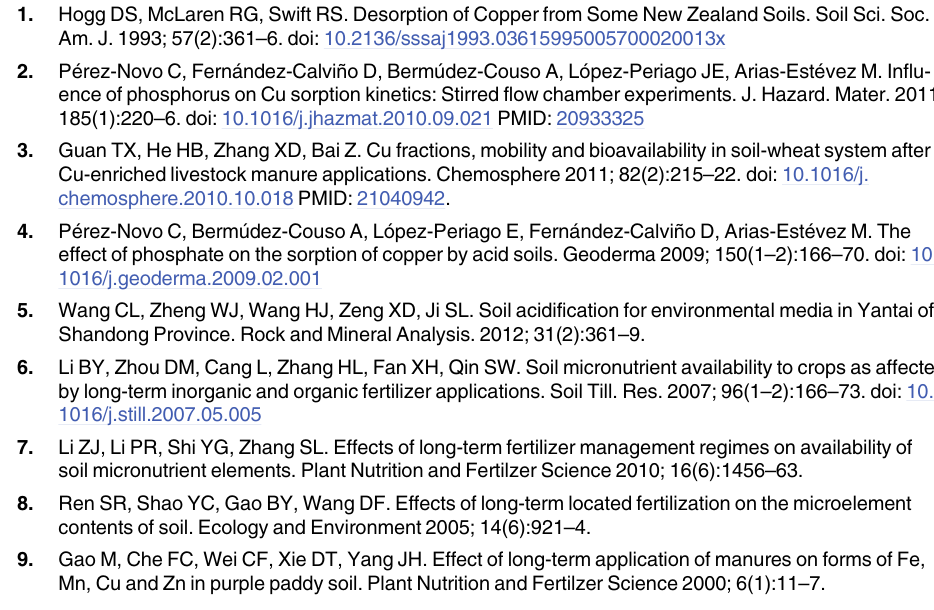
(DOCX) S2 Table. Soil Cu fractions in different cropping systems (mg kg -1 ). S3 Table. Soil Cu fractions in cropping systems with fertilisation treatments (mg kg -1 ). (DOCX) S4 Table. Correlation of Cu fractions and